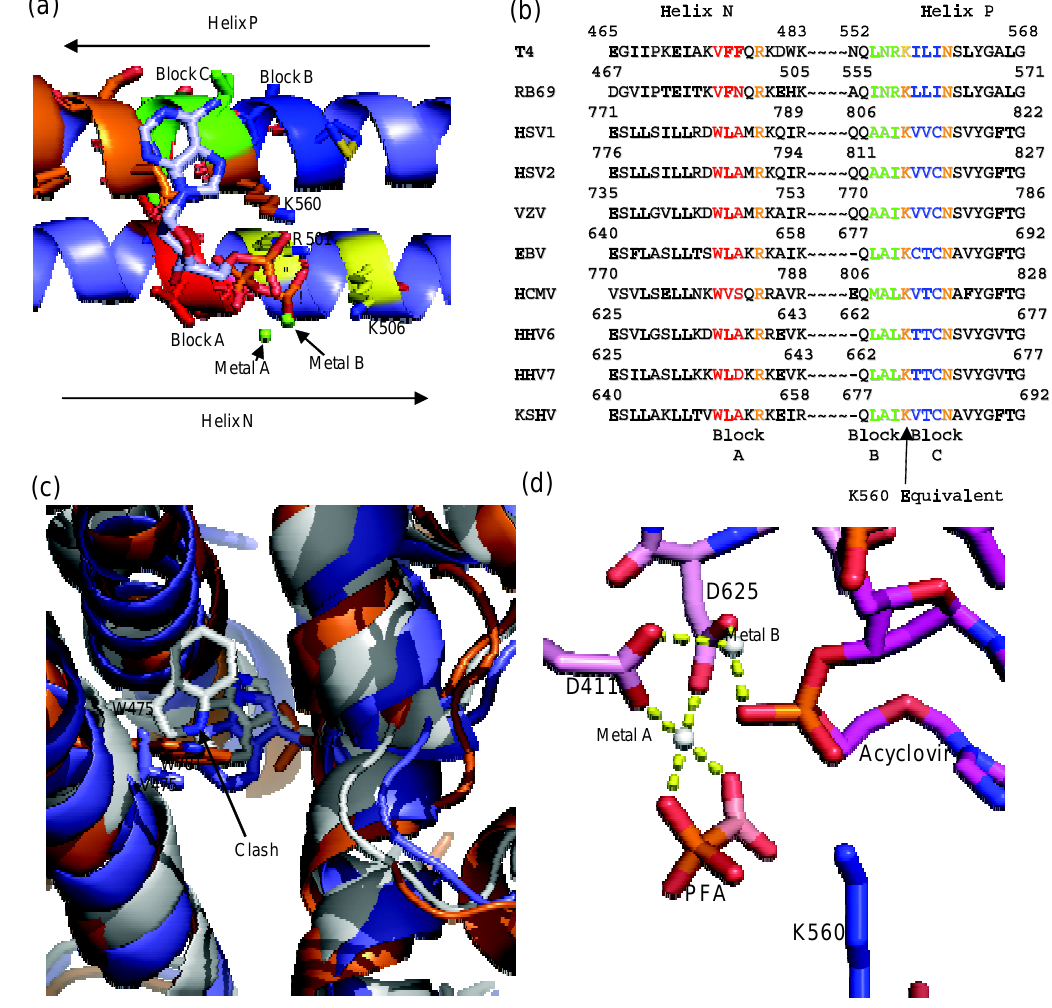
Figure 4. ( a ) Diagram of RB69 Fingers domain showing location of ABC block mutation relative to dNTP binding residues. Motif B residues are in orange, Tri-phosphate interacting residues on Helix N are in yellow, Block A is in red, Block B is in dark blue and Block C is in yellow. Aligned image of pdb 3LDS (dNTP) and pdb 3KD5 (N and P helix). ( b ) Sequence alignment of RB69 and herpesviridae sequences showing location of block mutations. ( c ) Diagram showing clash between W478 of Block A and W365. RB69 ABC5 is in white (3KD5), RB69 WT is in blue (pdb 1IH7) and HSV1 UL30 is in orange (pdb 2GV9). ( d ) Diagram of RB69 ABC5 block mutations active site showing phosphonoformic acid binding in β and γ phosphate position and with acyclovir in the pre-translocation position (pdb 3KD5). Images were generated using Pymol [23]. Alignment was generated using Geneious [24].